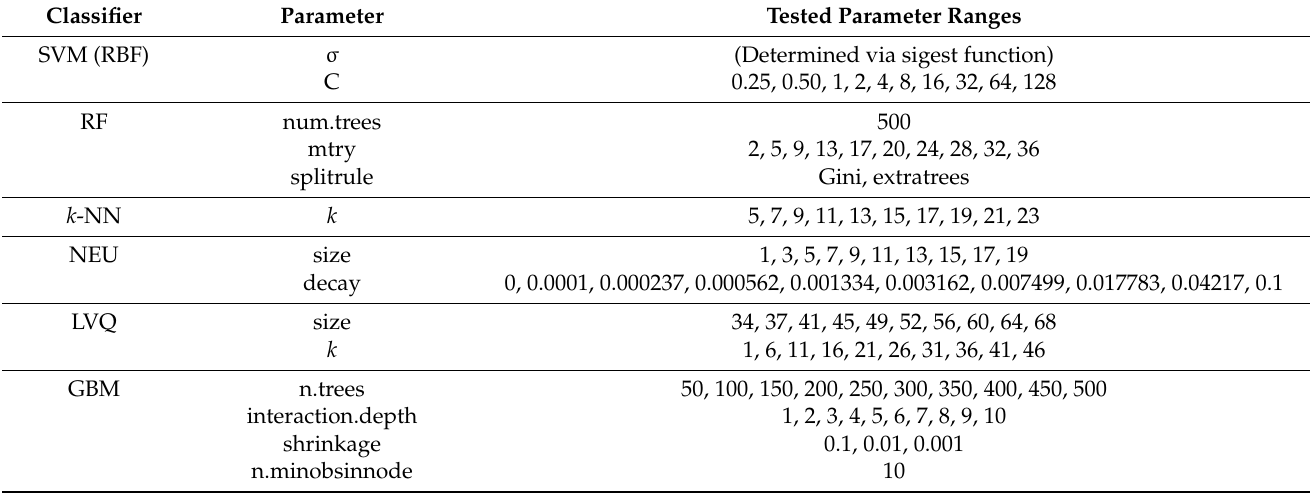
Table 5. Range of tested parameter values for SVM, RF, k -NN, NEU, and LVQ classifiers.